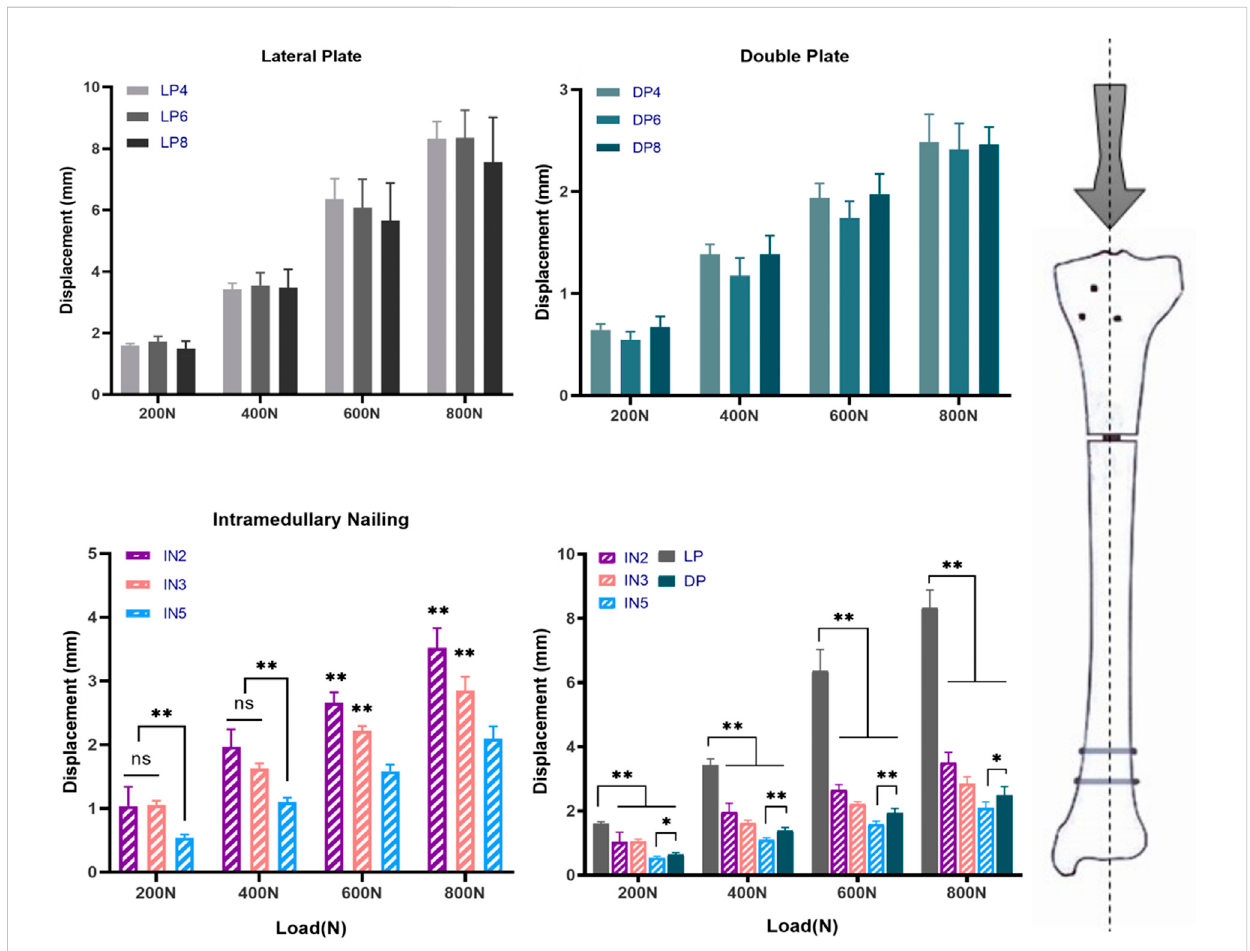
FIGURE 3 The different fi xation modalities: lateral plate fi xation groups (LP), double plate fi xation groups (DP), intramedullary nailing groups (IN) and multiple comparisons. Values represent the mean axial displacements (measured in mm). (ns, no signi fi cant difference; * p < 0.05; ** p < 0.01).